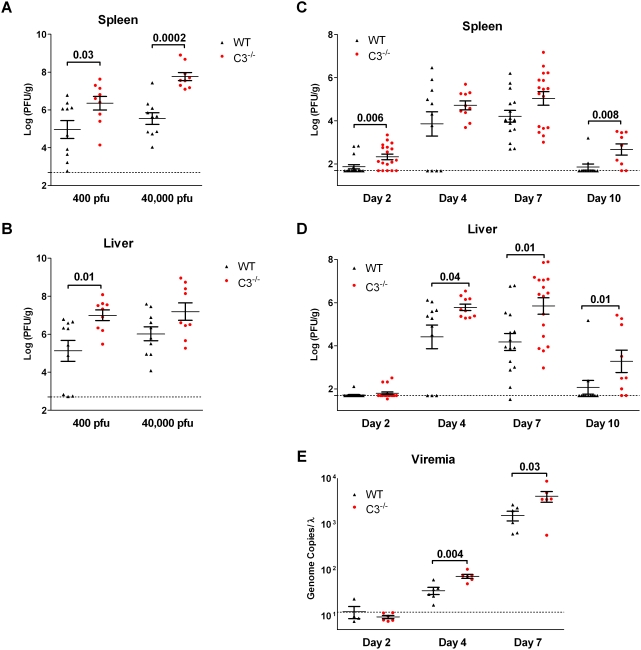
C3 deficiency promoted earlier dissemination to and increased viral titers in the target organs.C3−/− and wild-type mice were infected by the footpad or ear pinna route and sacrificed on day 2, 4, 7, or 10 post-infection. The viral titer of the spleen (A,C) or liver (B,D) was determined by direct plaque assay and is expressed as the log10 plaque forming units (PFU)/g tissue. The level of viral DNA in whole blood was measured using quantitative PCR (E). The scatter plots show the viral burden of each wild-type (WT, black, ▴) and C3−/− (red, •) animal. The error bars indicate SEM. The wild-type and C3−/− mice were compared, and P values <0.05 are reported above the bracket. The dotted line represents the limit of detection for the assay. (A,B) Mice were infected with 400 or 40,000 pfu of ECTV in the footpad and sacrificed on day 7 post-infection. At 400 pfu, all animals had virus detected in either the spleen or liver. (C–E) Animals were infected with ∼700 pfu of ECTV via the ear pinna. Mean viral titers±SEM or genome copies±SEM from the scatter plots are also plotted against time in a line graph (Figure S1).